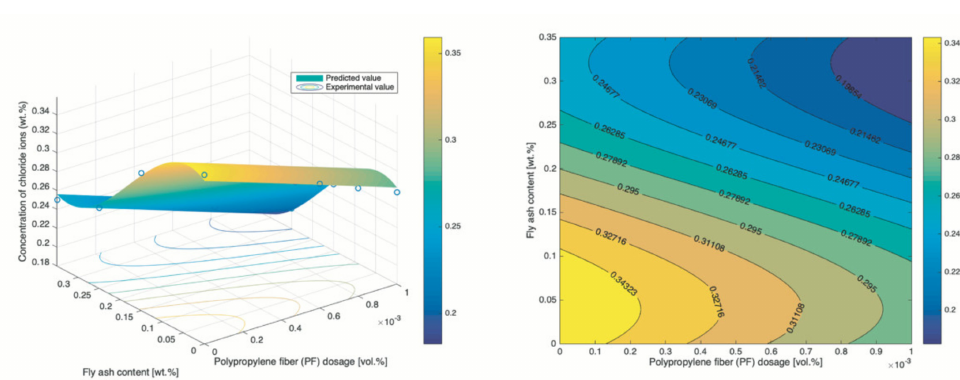
Figure 13. Respond surface and contour map of the quadratic model.